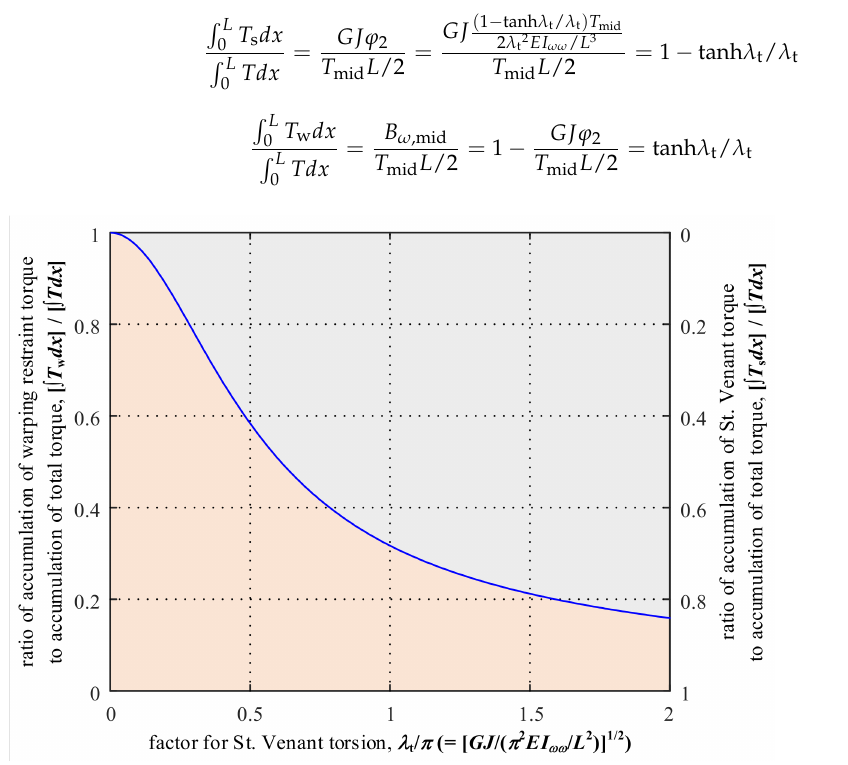
Figure 7. Effect of the factor for St. Venant torsion on the ratio of the accumulation of warping restraint torque/St. Venant torque to the accumulation of total